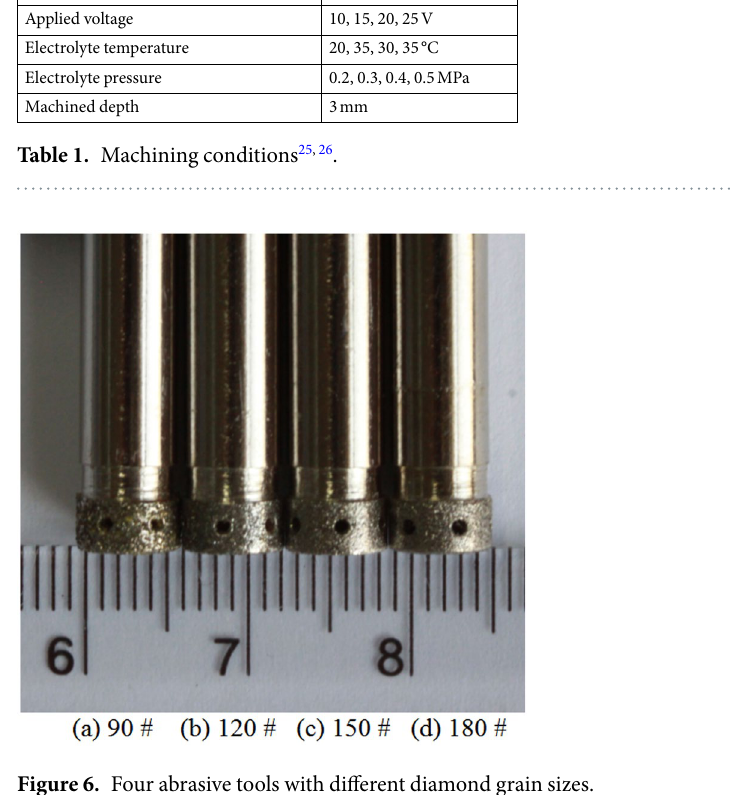
Figure 6. Four abrasive tools with different diamond grain